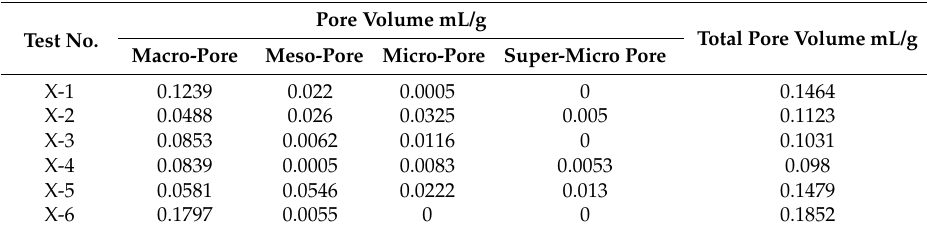
Figure 5. Paths for experimental procedures (modified from [32]).